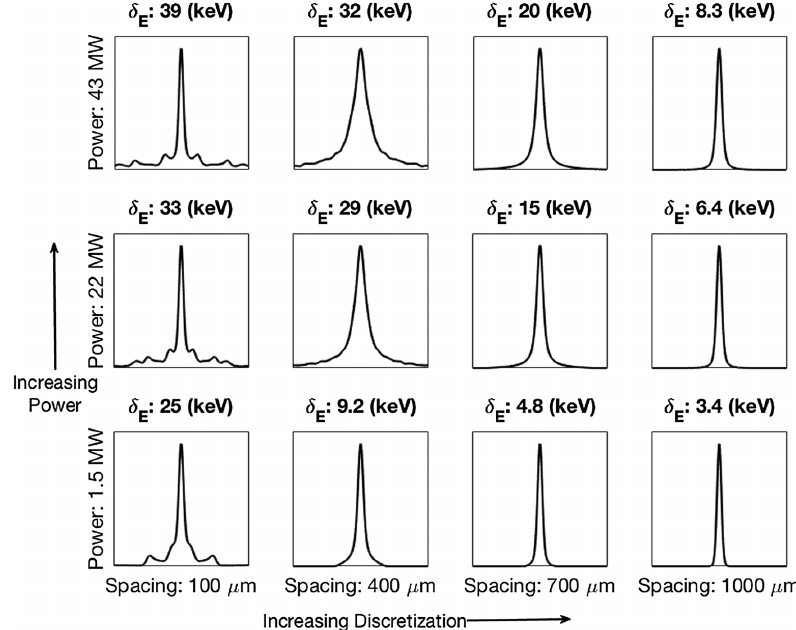
FIG. 6. Energy distributions and their averaged rms energy spread ( δ 1 = 5 of spacing. The change in interbeam spacing effectively sweeps the discretization of the beam. Ripples in curves intensify due to small beamlet with increasing power. Plots are normalized with respect to maximum